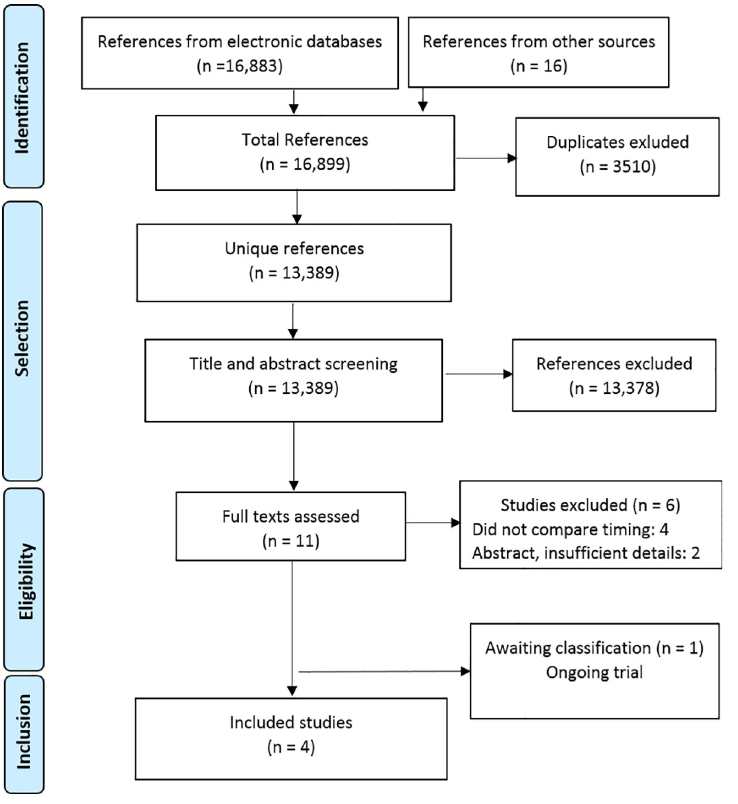
Fig 1. Flowchart of the process of study